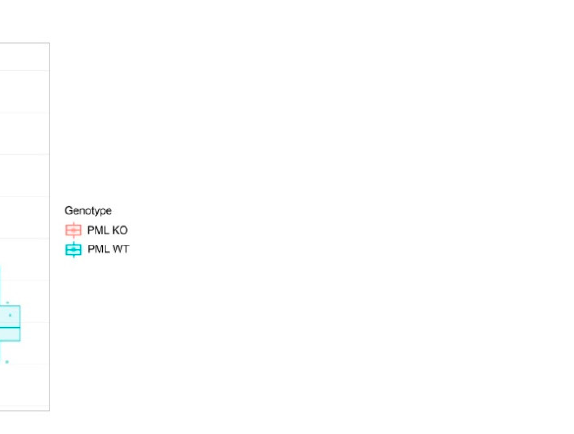
Figure 3. Elevated levels of PML bodies in basal epidermal cells during embryogenesis. ( A ) Schematic of epidermal cell layers during embryonic and postnatal development. Structural layers of epidermis at E13.5, E15.5, E17.5, and postnatal day (P) 0 is depicted. PML nuclear bodies are predominantly observed in the basal cell layer during embryogenesis. ( B ) Paraffin embedded sagittal sections obtained from developmental stage E13.5, E15.5, E17.5, and P0 were immunofluorescence (IF) labeled using antibodies against K15 (red) and PML NB (green). 4 ′ ,6-diamidino-2-phenylindole (DAPI) is shown in blue. The images are projections of multiple confocal Z-stacks. White rectangles highlight zoom-in of basal cells containing PML. ( C ) Quantitative assessment of PML bodies in different layers of epidermis obtained from E13.5, E15.5, E17.5, E18.5, and P0 mice. Each data point represents the average of PML bodies per cell from a single embryo.